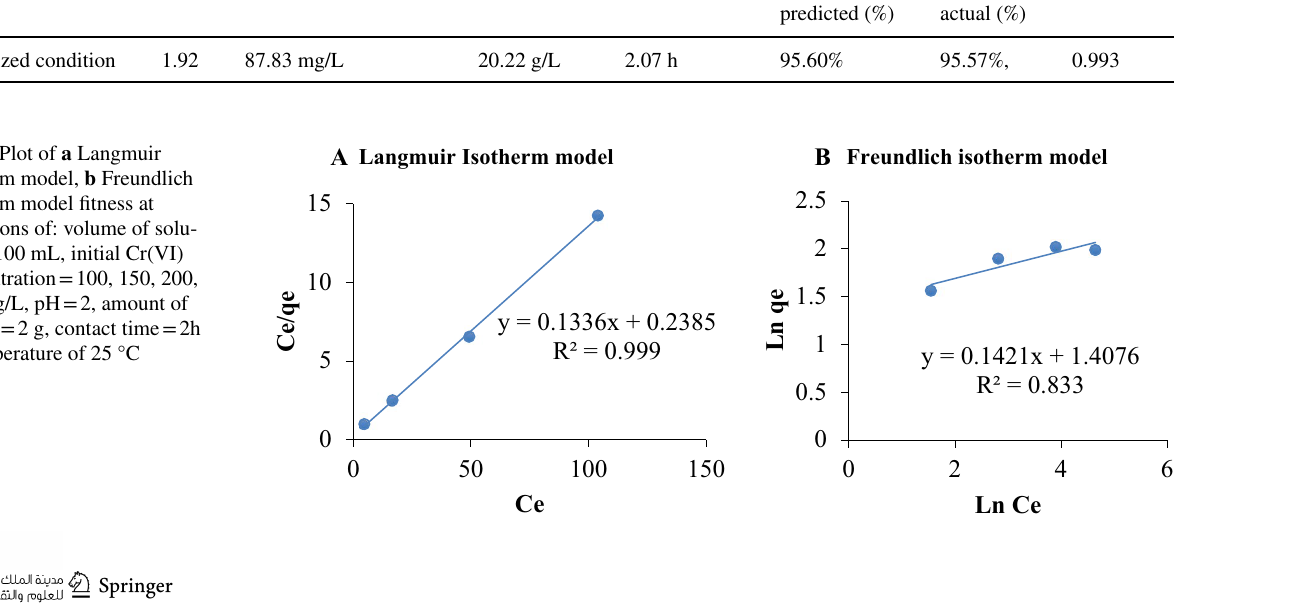
predicted (%) actual (%)